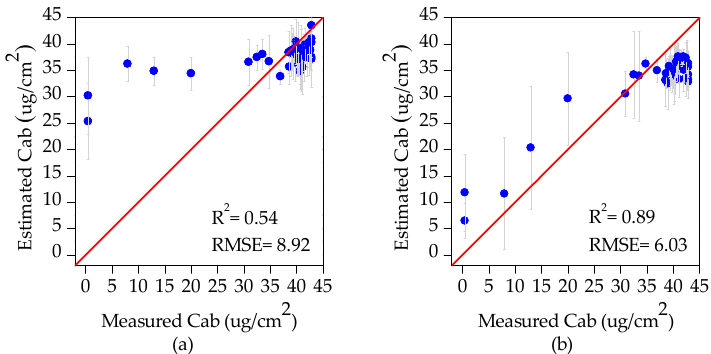
Figure 5. Measured vs. estimated Cab (215 samples) using different tree crown delineations: ( a ) from only hyperspectral segmentation; and ( b ) from only lidar segmentation.